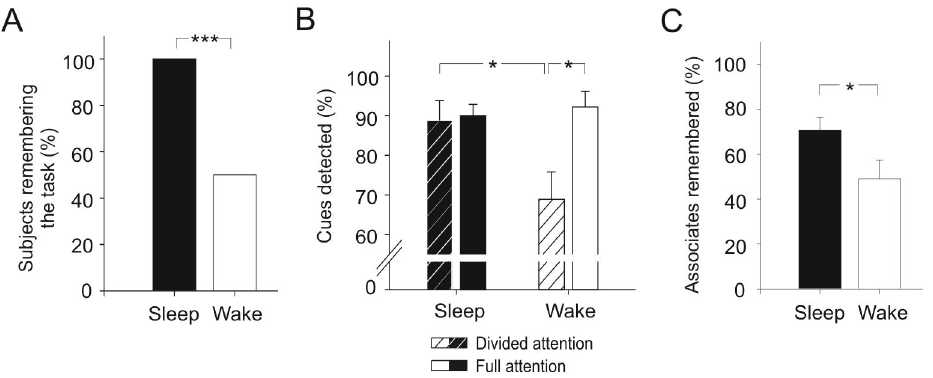
Figure 2. Prospective memory after sleep and wakefulness. (A) A significantly greater percentage of subjects who slept in the night after prospective memory instruction (sleep group) compared to subjects who stayed awake (wake group) retrieved the intention at a retest two days later, i.e., detected at least one cue in the lexical decision task. (B) The percentage of cue-words detected (a measure of the prospective component) differed in sleep and wake groups depending on whether subjects paid full attention to the task or engaged in parallel in a secondary (auditory attention) task. Subjects who slept after instruction of prospective memory were completely unaffected by divided attention, whereas wake subjects were strongly impaired in cue detection specifically during divided attention conditions. (C) The percentage of recalled word associates relative to the number of cues detected (measuring the retrospective component) was higher in sleep compared to wake subjects. Means ± SEM are shown. * p < 0.05, *** p <